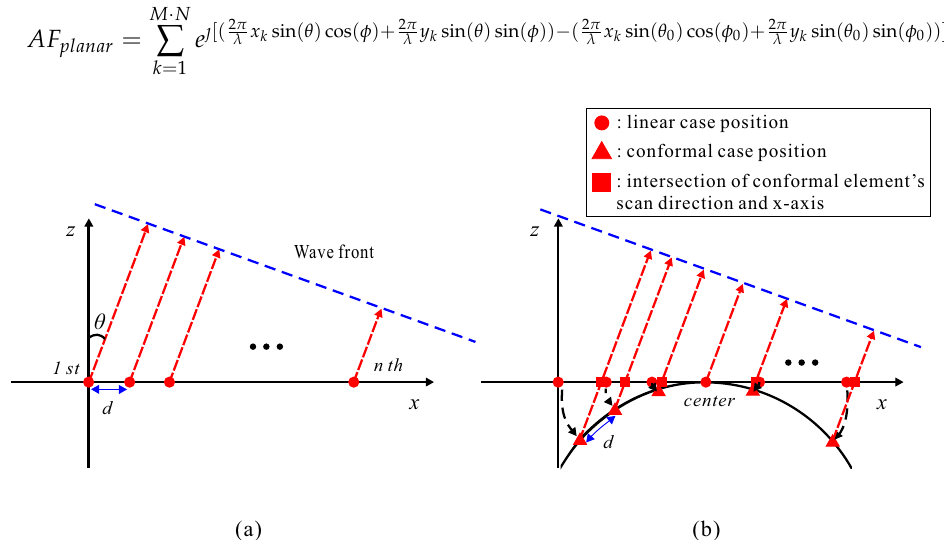
Figure 4. Arrangement shape on the XZ plane: ( a ) linear array (planar array) shape and ( b ) curved array (conformal array)